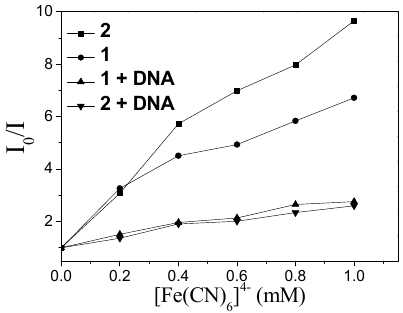
Figure 4. Luminescence quenching curves of 1 ( ● ), 2 ( ■ ), 1 -DNA ( ▼ ), and 2 -DNA ( ▲ ) by [Fe(CN) 6 ] 4 – . [Ru] = 5 μ M, [DNA]/[Ru] = 80.